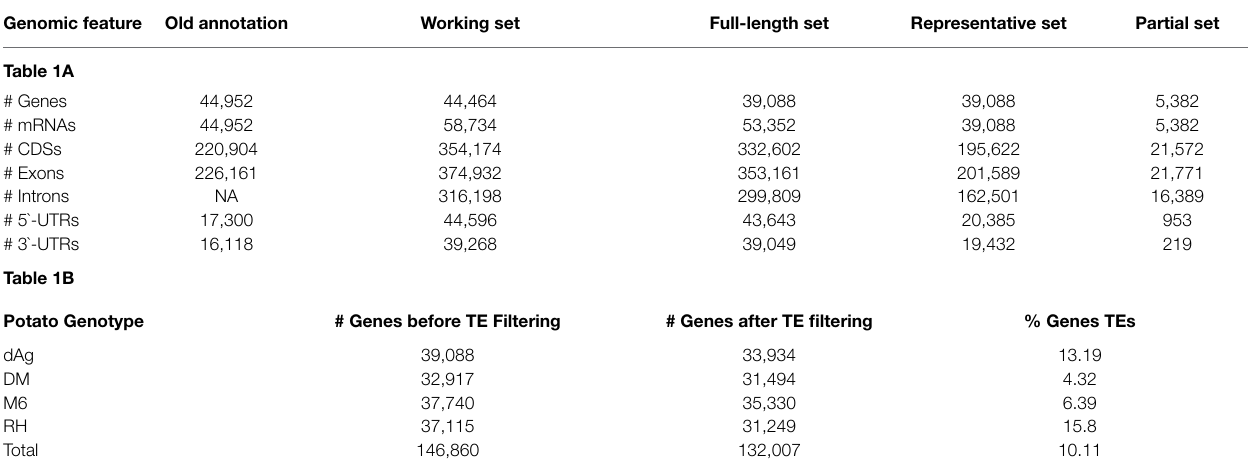
TABLE 1 | (A) Improved gene annotation of dAg; (B) Non-TE genes of potato